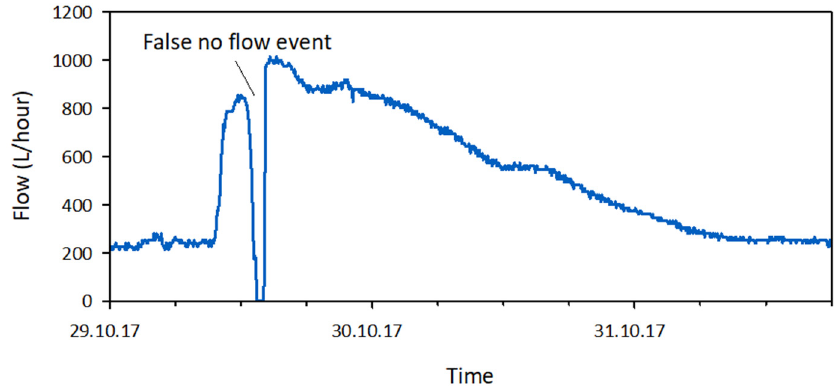
Figure 9. Example of a false no-flow event in the discharge data, due to temporary clogging of the funnel of the flow sensor during stormflow.